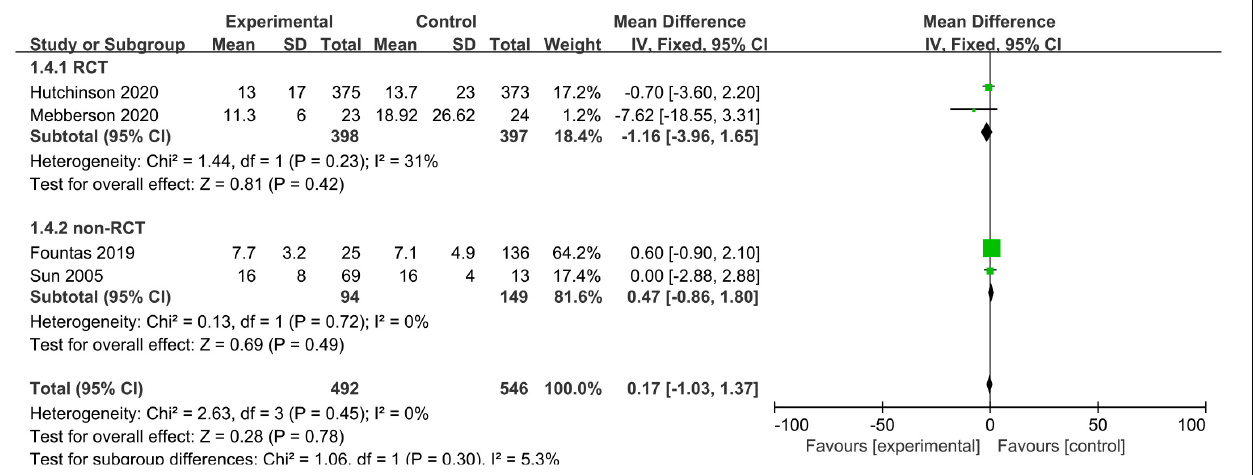
FIGURE 5 | Meta-analysis of adjuvant corticosteroid group compared to the surgery alone group on length of hospitalization.